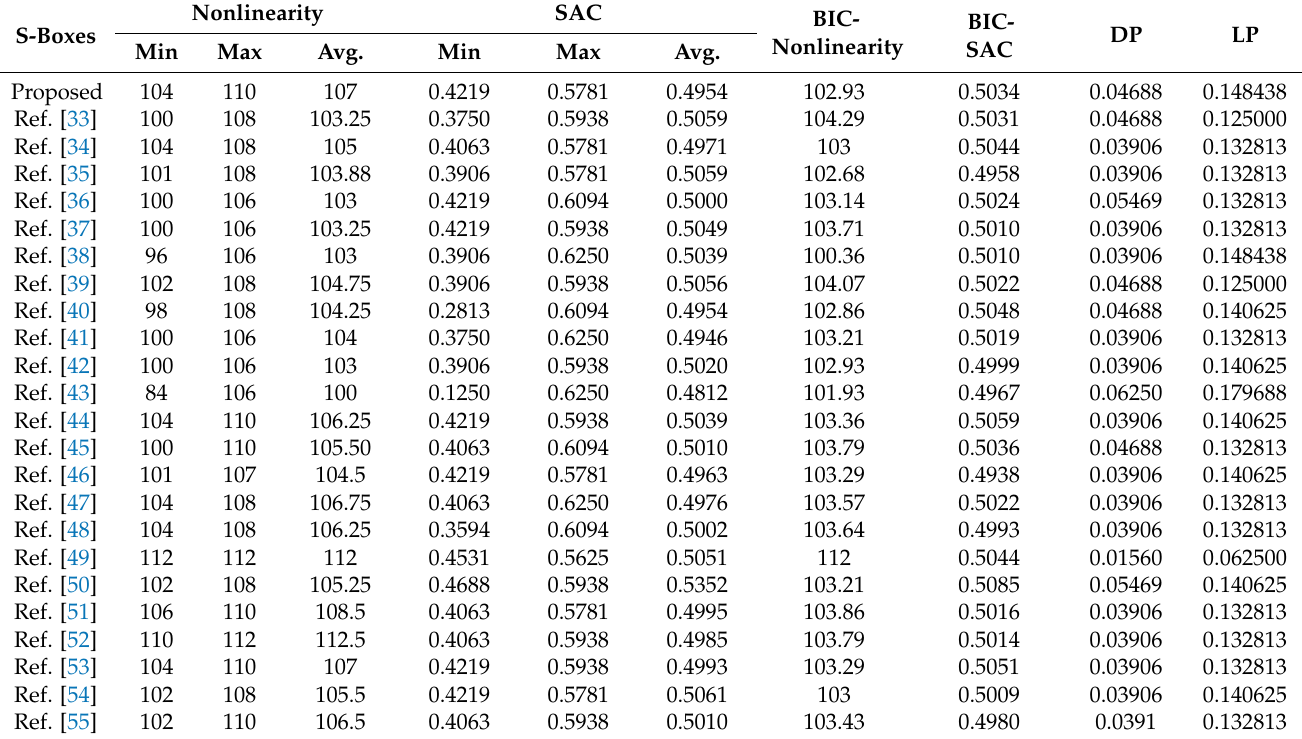
Table 2. Cryptanalysis comparison results of